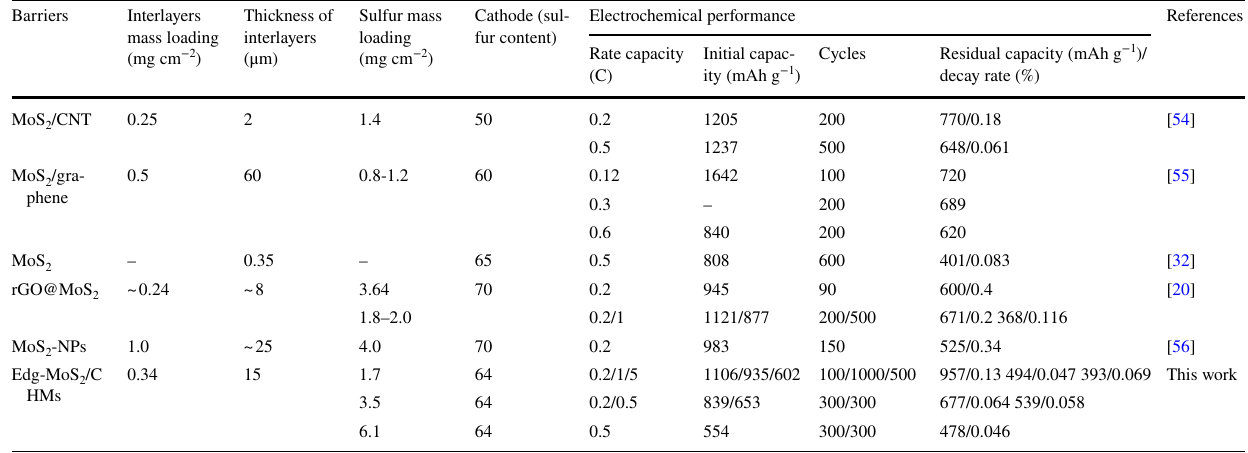
Table 1 Systematic performance comparison between Edg‑MoS 2 /C HMs and previously reported similar materials Barriers Interlayers mass